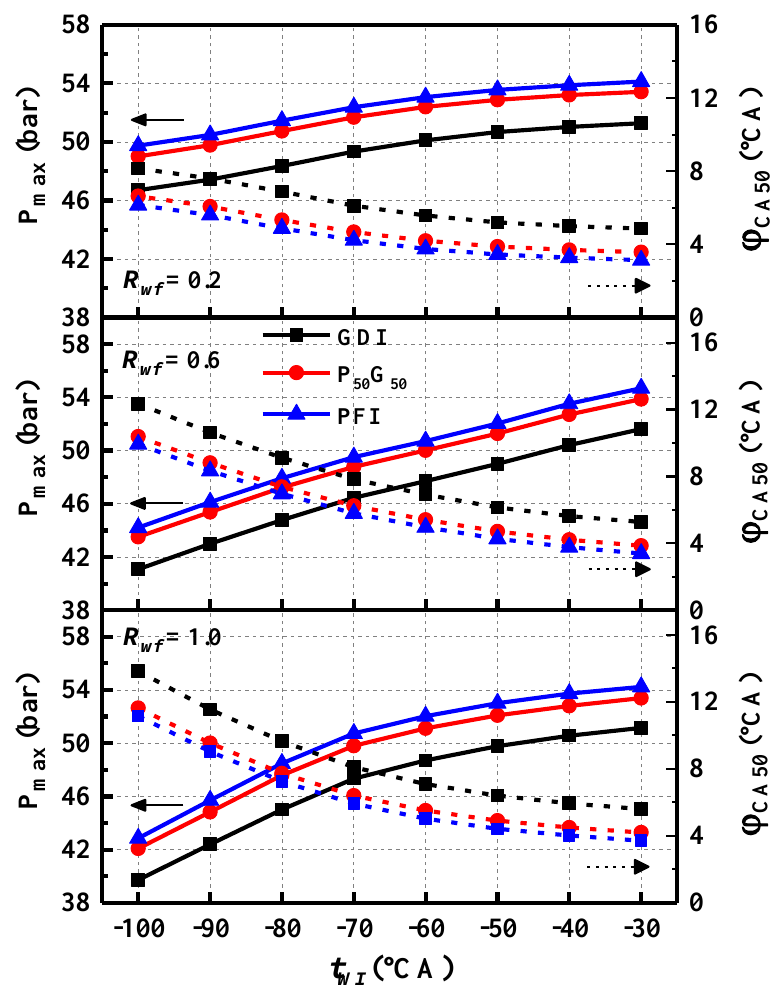
Figure 14. Effects of t WI on P max and ϕ CA 50 ( R wf = 0.2, 0.6, 1.0).